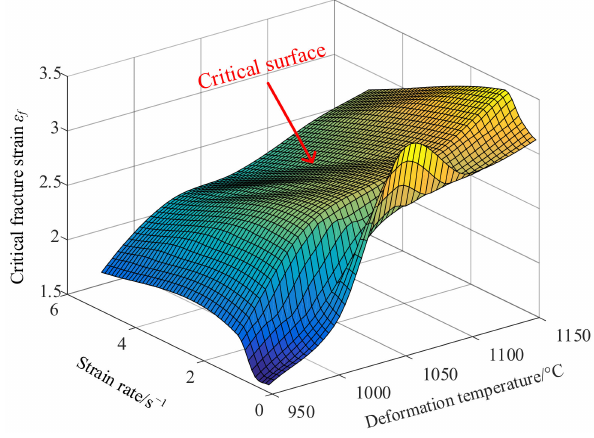
Figure 5. The relationship between critical fracture strain, strain rate, and temperature.